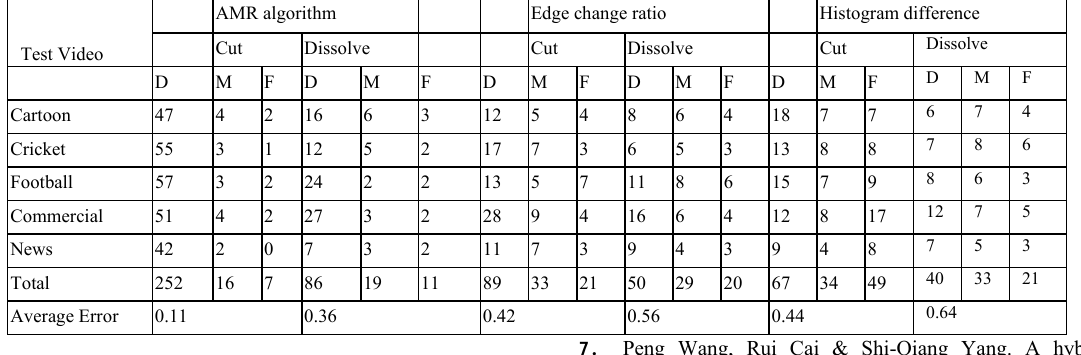
Table 5. Performance comparison of various algorithms D –Correct detections M – Mis-detections F – False